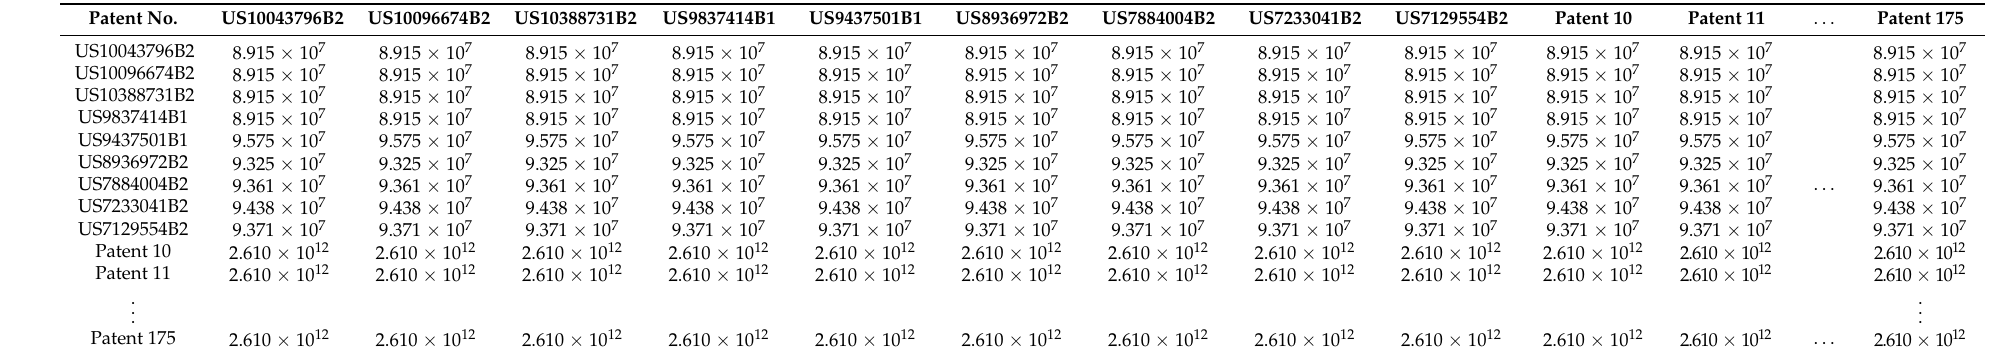
Table 9. The matrix T d of the second empirical case.